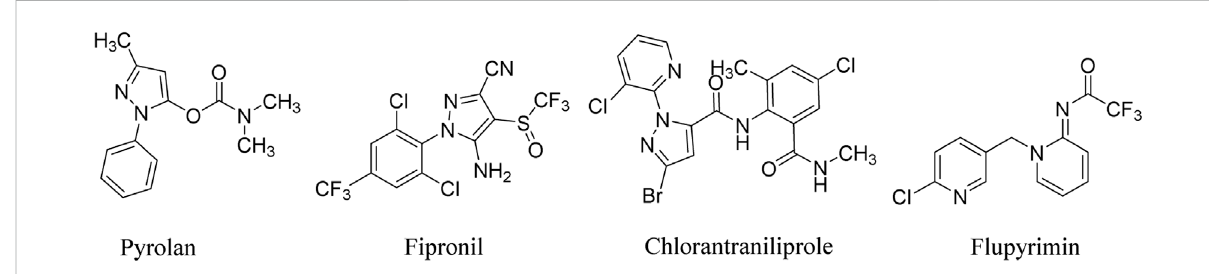
FIGURE 1 Structures of representative pesticides containing pyrazole moiety.